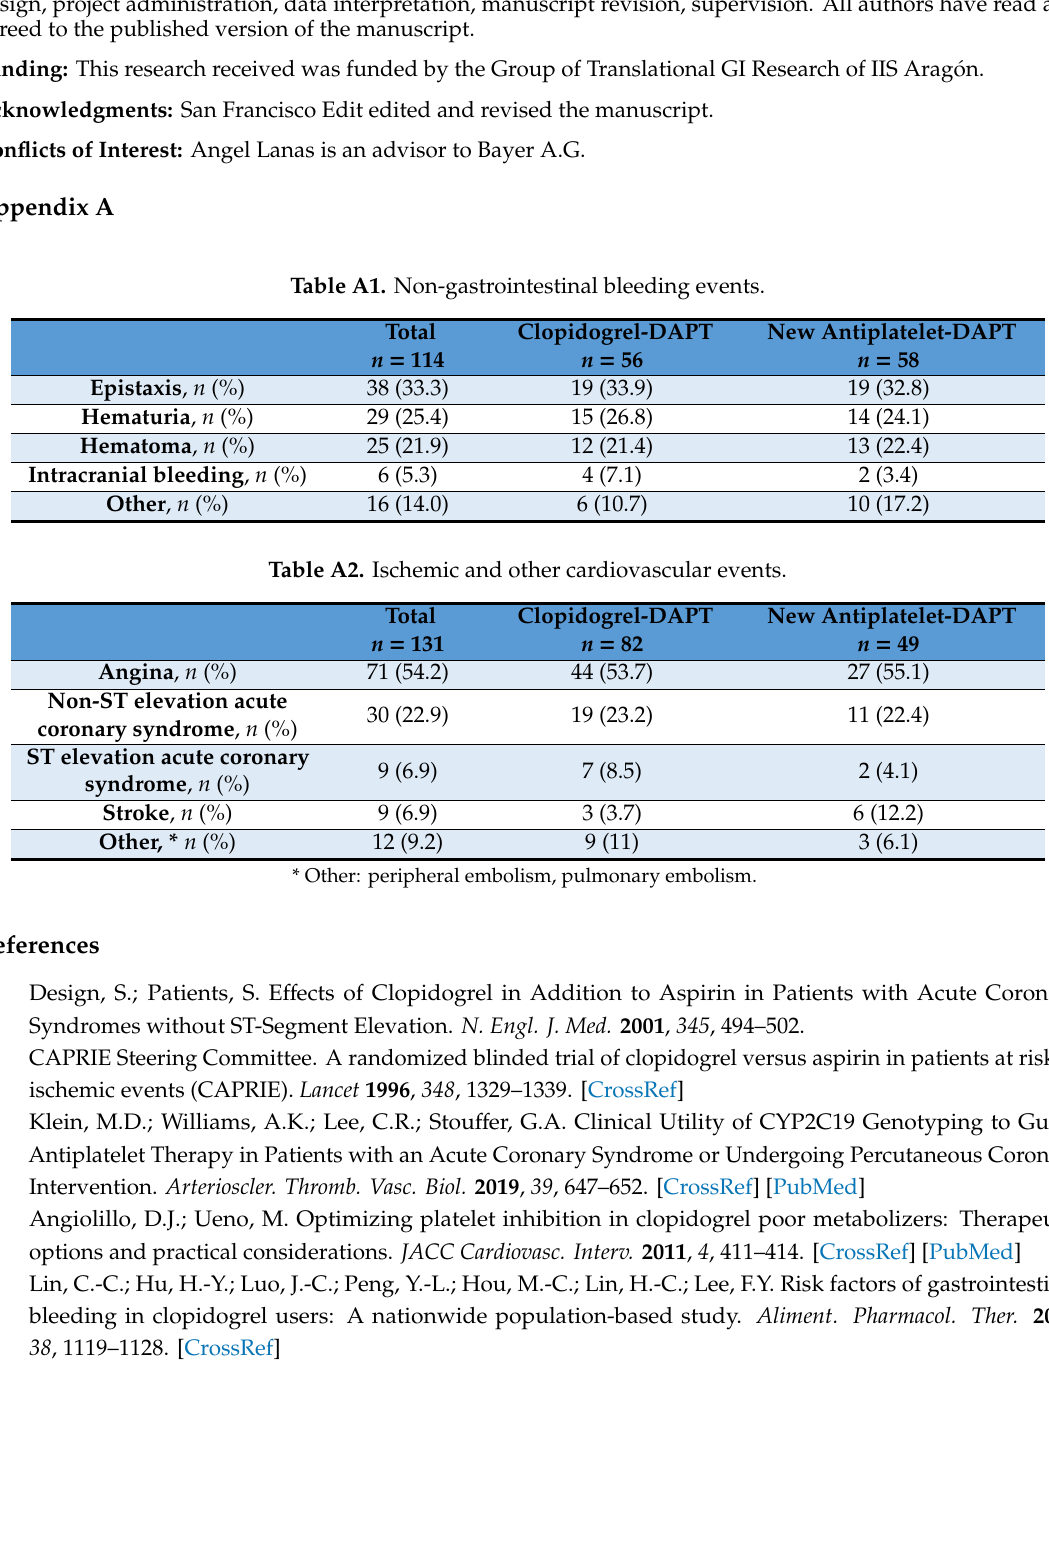
Figure S1: Study flowchart, Table S1: STROBE checklist.